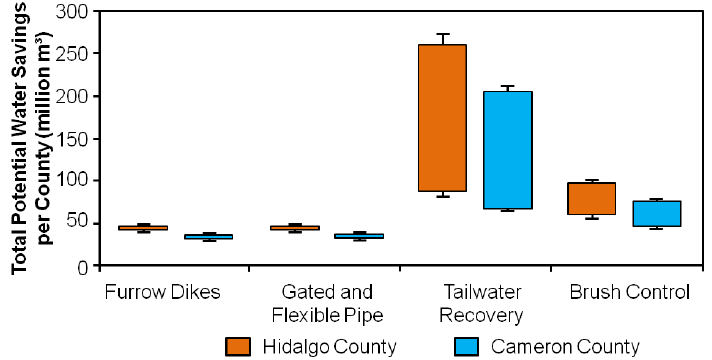
Figure 12. In addition to the variation for each BMP, the water savings varies in each county. With the high irrigation water use in both Cameron and Hidalgo counties, each county has a great potential for water savings through improved irrigation efficiency. Equation 3 was employed to determine these estimated savings.